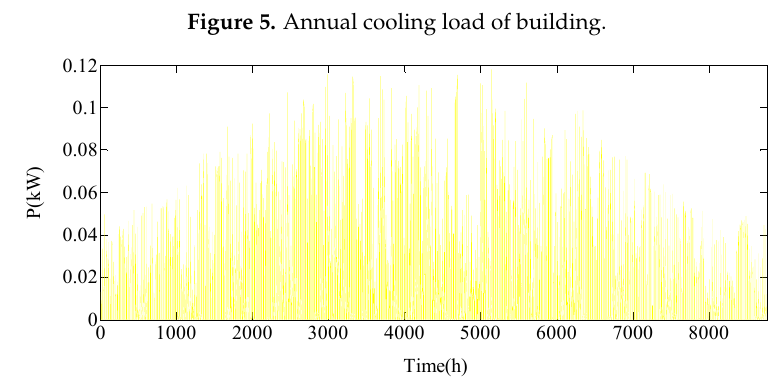
Figure 6. Annual output of single photovoltaic plane. Table 2. Description of the simulated building.